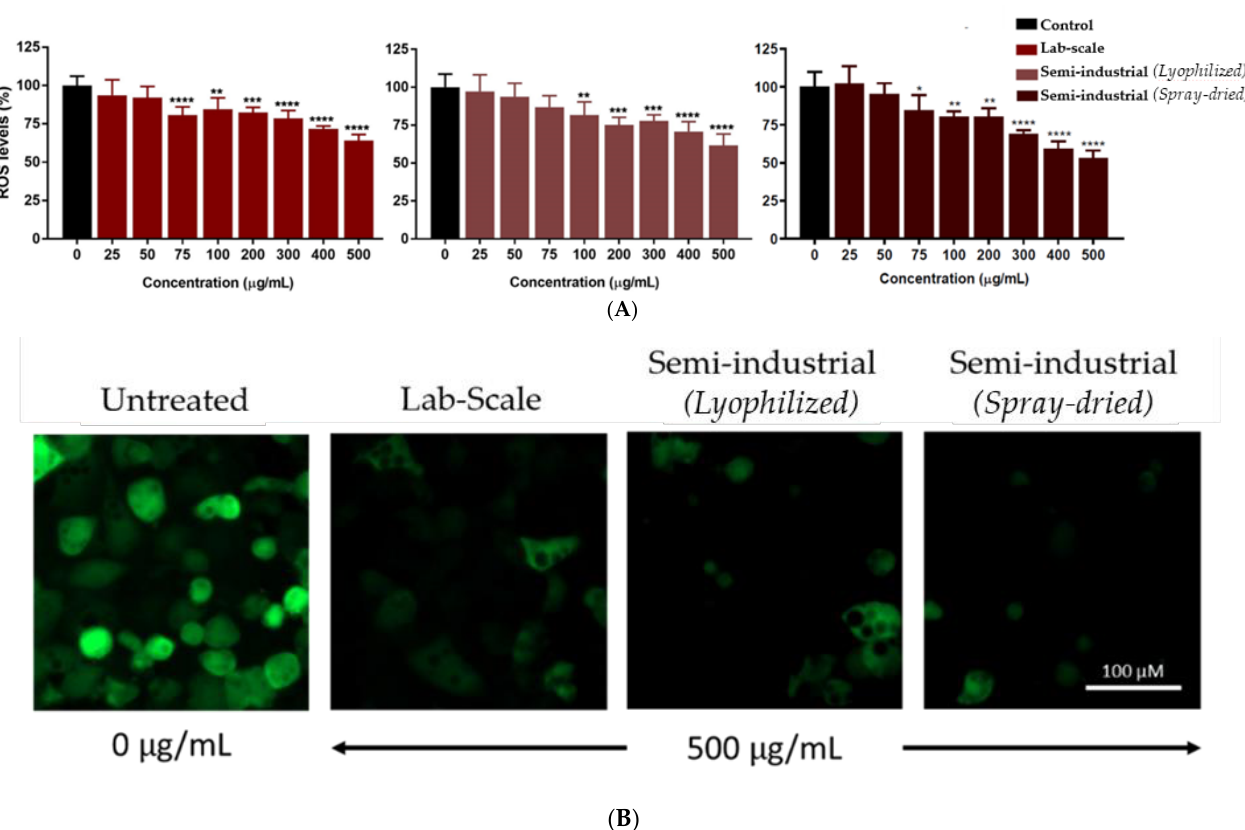
Figure 7. ( A ) ROS reduction levels in 3T3-L1 adipocytes (mean ± SD, n = 6). The untreated sample was considered 100%, and the reduction in the fluorescent signal was normalized against its value. All the values were viability-corrected as described in the methods section. Statistical significance was calculated using untreated samples (black bars) as a reference (* p < 0.05, ** p < 0.01, *** p < 0.001 and **** p < 0.0001). ( B ) Representative fluorescent images of H 2 DCFDA staining after treatment with 500 µg/mL extracts in comparison with the untreated sample.